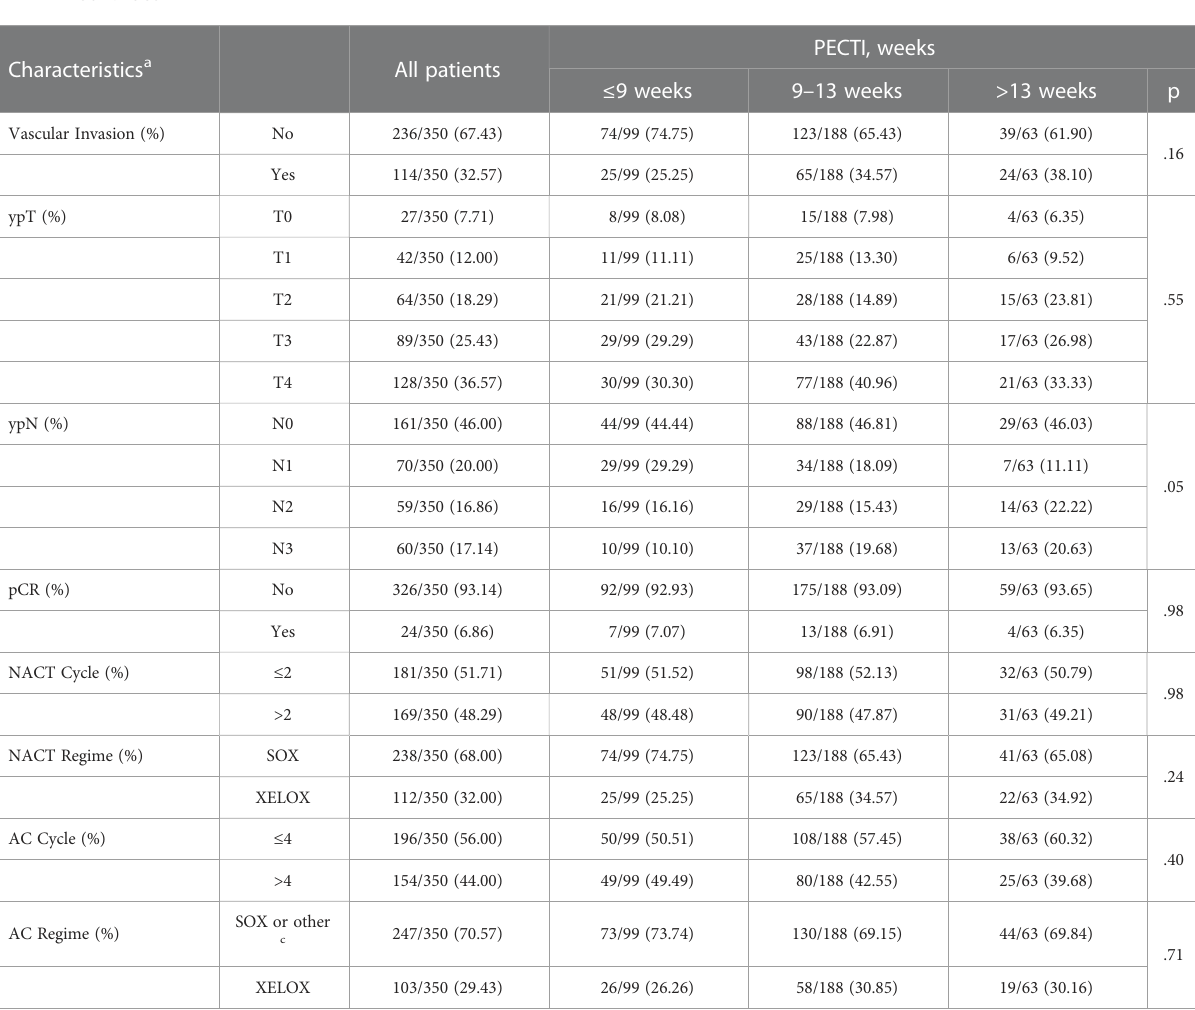
(Figure 7B) revealed good model consistency. N ∗ K cross- validation was performed for the nomogram model, and the mean AUC was 0.79 (IQR, 0.75 to 0.83) at 5 years when N = 400 and N = 5 (Table S3). DCA and CIC indicated that patients could obtain better clinical bene fi ts using the developed nomogram, which had a relatively high true-positive rate under a wide range of risk thresholds (Figures 7C –